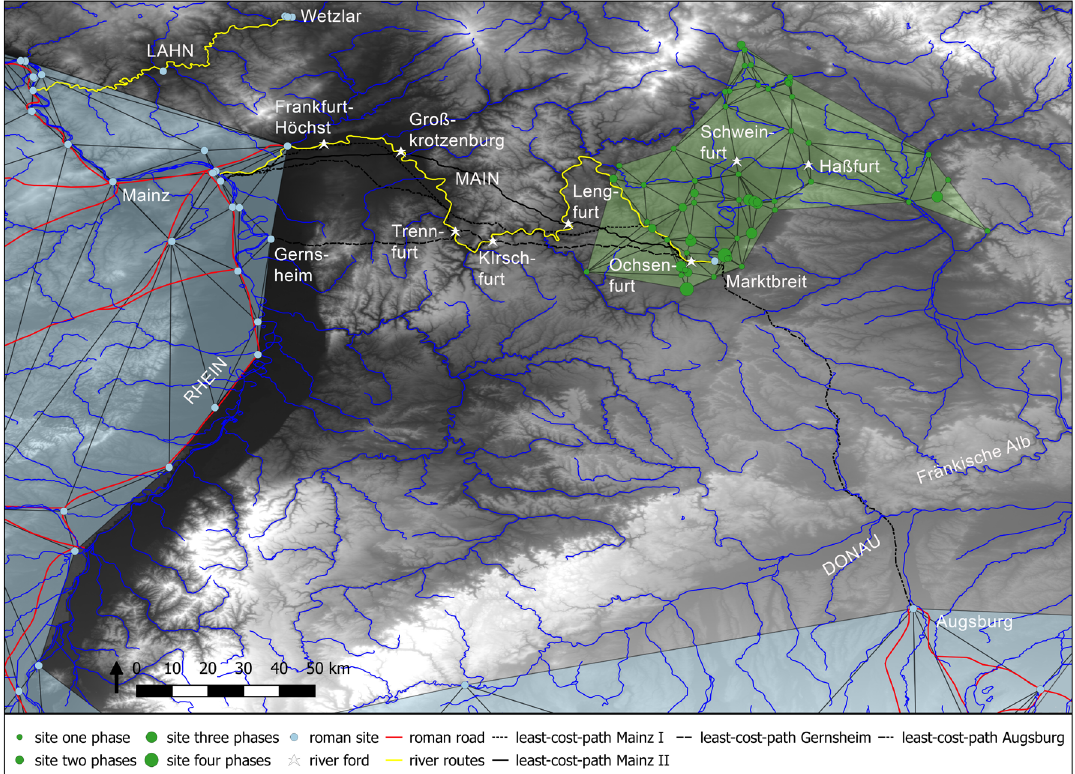
Figure 4. Research area in the Early Roman Iron Age (Eggers Phases A-B1, 15 BC-70 AD). The Germanic sites in the Barbaricum are indicated by green dots whose size corresponds to weighting based on duration of settlement usage. Natural fords on the Main are indicated by white stars; Roman sites are indicated by light blue dots and roads by red lines. Although not extant in the Germanic territories to the east, several roadways are known in the Roman territory to the west. For both areas settlement relationships with one another (next-neighbor relationships) were calculated with Delaunay Triangulation in the GIS, cleaned up and diagrammed. Yellow lines highlight Lahn and Main River routes for Roman incursions into the Barbaricum. Two poten- tial overland routes to the Roman fort at Marktbreit in the inner Barbaricum are similarly highlighted with red lines. Sources: see Fig. 3, GIS